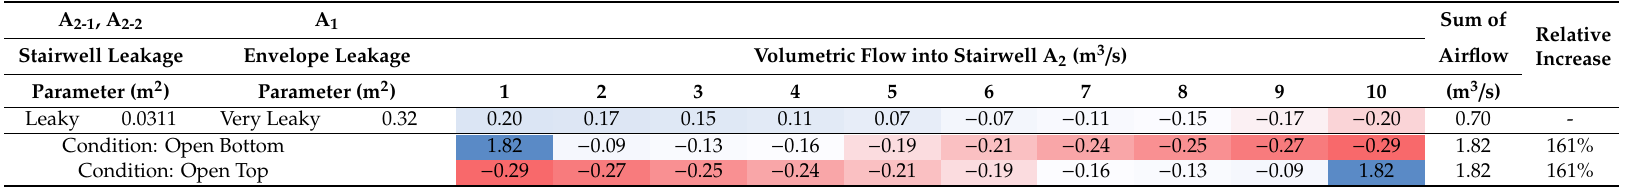
Table 5. Airflow through stairwell doors for Open Bottom and Open Top